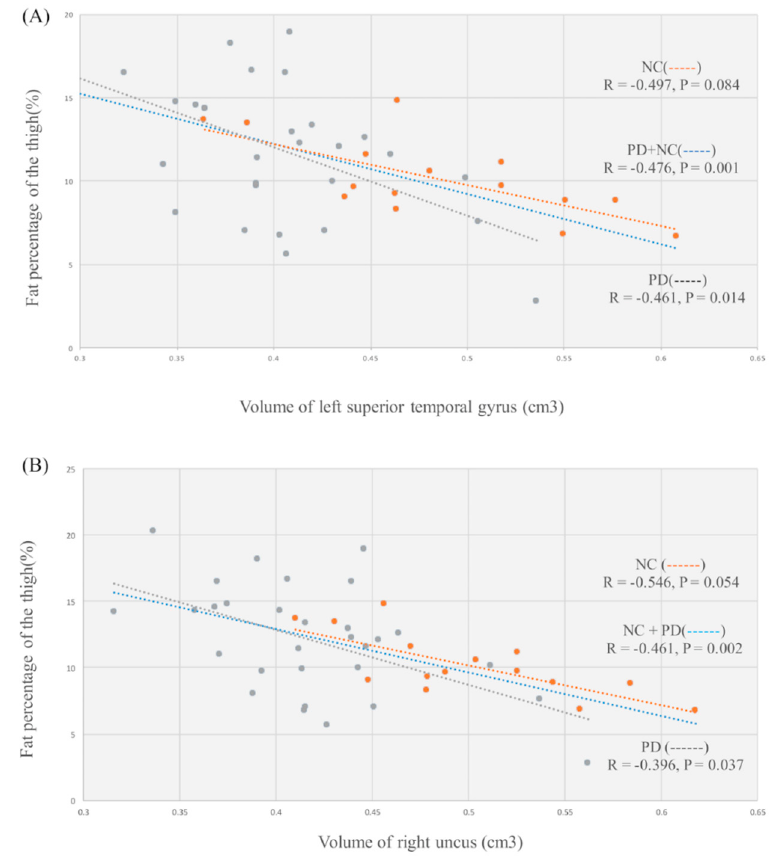
Figure 2. Relationship between thigh fat percentage and regional gray matter volume (GMV). ( A ) Lower gray matter volume of the left superior temporal gyrus was associated with increase in fat percentage of thigh. ( B ) Lower gray matter volume of the right uncus was associated with increase in fat percentage of thigh.